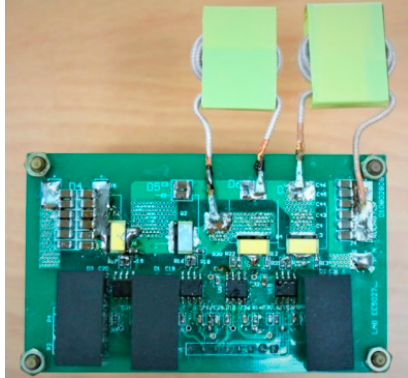
Figure 14. Efficiency performance with fixed switching frequency and variable switching frequency in TCM operation: ( a ) forward direction; ( b ) reverse direction. Figure 15. The 48 W prototype of the high-voltage-gain bidirectional DC–DC converter. Figure 15. The 48 W prototype of the high-voltage-gain bidirectional DC–DC